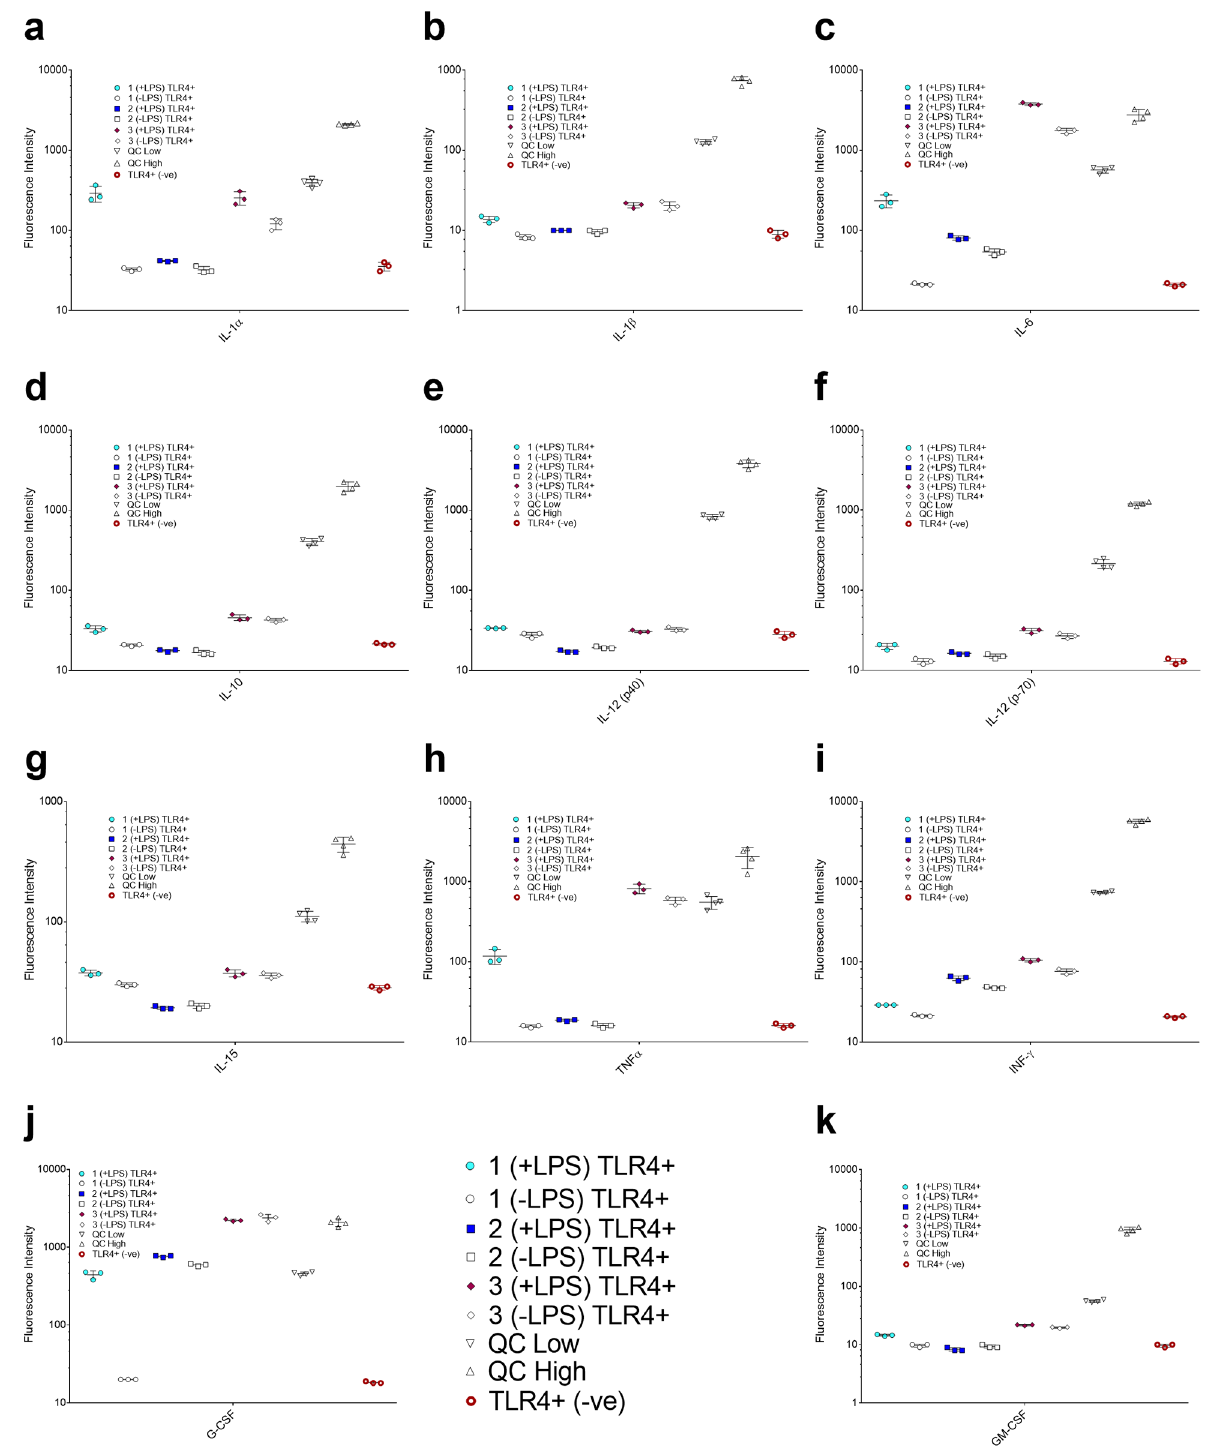
Fig 4. Comparative cytokine expression between conditions 1, 2 and 3 in TLR4(+) cells. Cluster plot of results of three independent replicates, plotted as fluorescence intensity for each individual cytokine, with error bars indicating the standard deviation of the mean for each condition. QC High and QC Low were high and low quality controls of unknown concentration which were provided by the manufacturer. The negative cell control is the basal cytokine expression of the cells under normal growth conditions with no LPS. Each subset (a-k) is a graph of an individual cytokine as indicated on the x-axis. Y-axis is plotted on a logarithmic scale to allow for viewing a large range of values on a single plot, but the results have not been altered. Additional plots on a linear scale are displayed in S4 and S5 Figs.